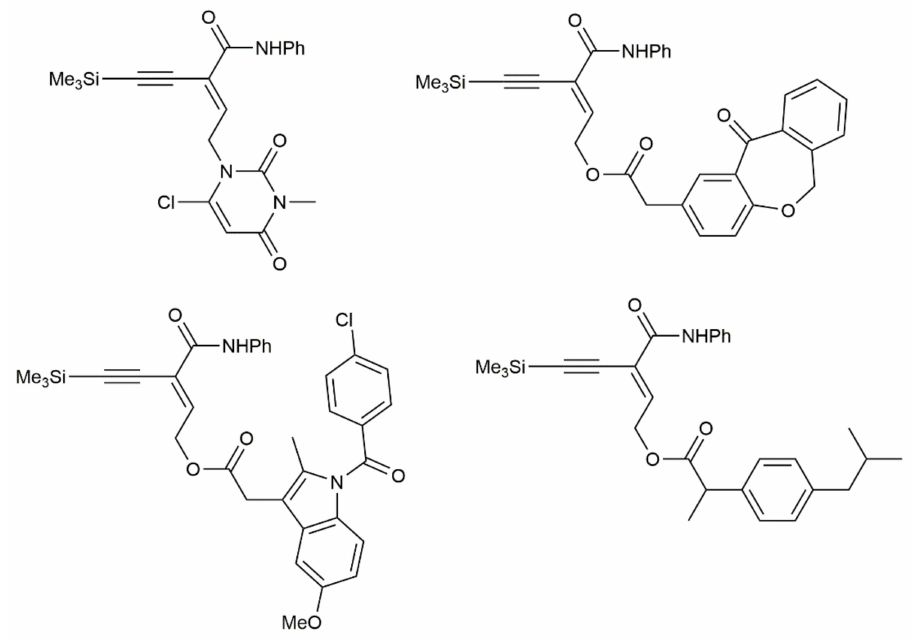
Figure 5. The structure of some elaborated amides containing bio-relevant